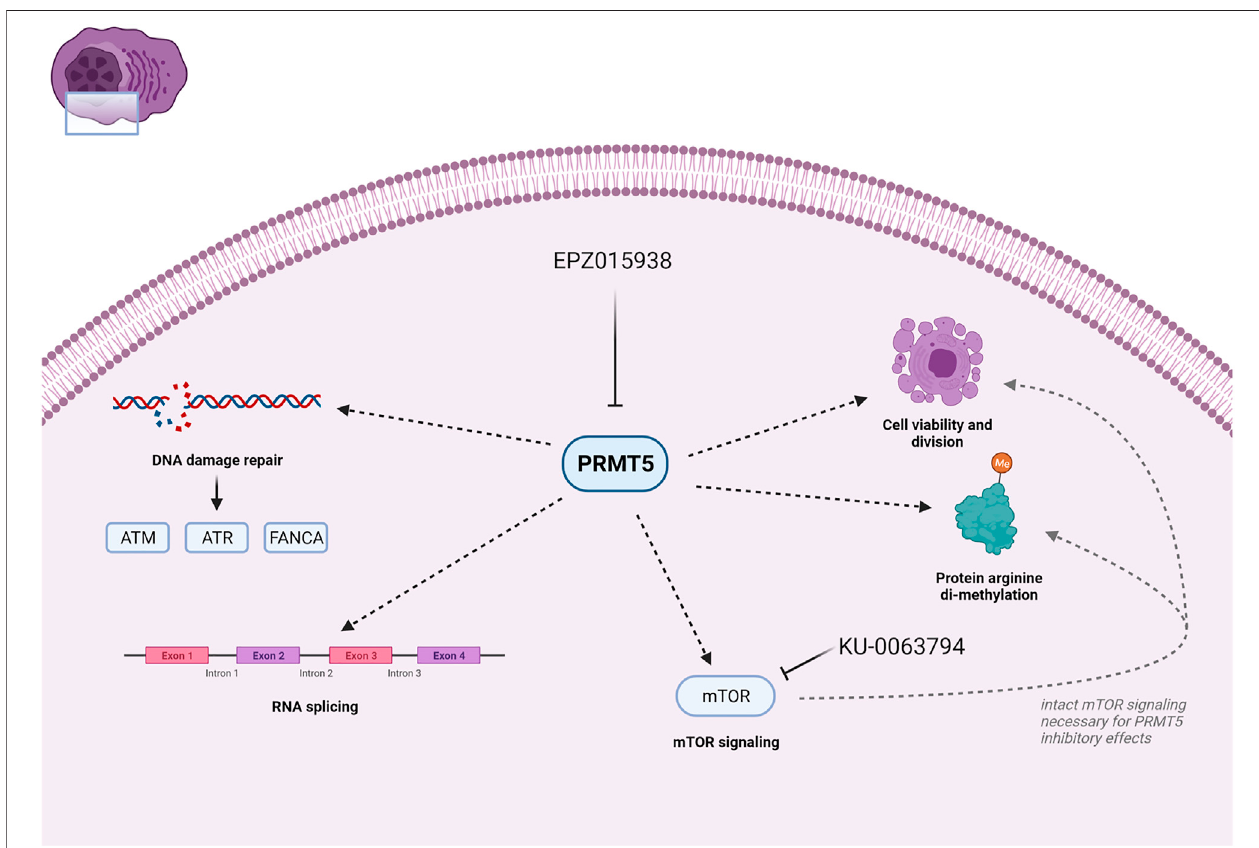
FIGURE6| SchematicrepresentationofPRMT5functionandeffectsupontreatmentasevaluatedinthisstudy.PRMT5inhibitionbyusingi.e.,EPZ015938leadsto decreased DNA damage repair through a decrease in ATM/ATR and FANCA transcript and protein levels. Moreover, the function of PRMT5 as a regulator of mRNA splicing also plays a role in MM cellular processes and survival. Lastly, our study shows that mTOR signalling is important for PRMT5 function and has effects on cell viability, division and overall arginine di-methylation. Created with BioRender.